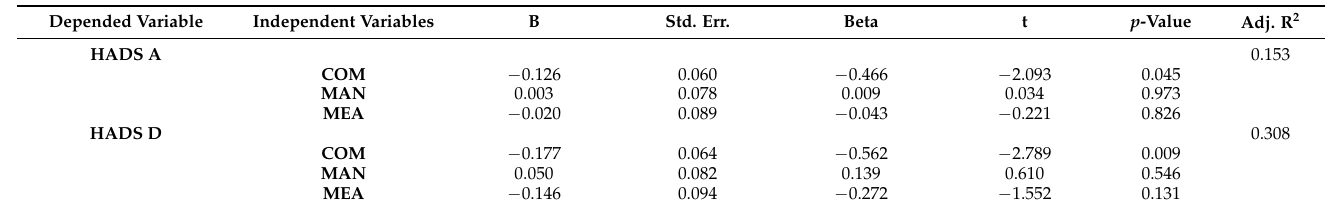
Table 5. Multiple linear regression analysis with HADS A and HADS D as dependent